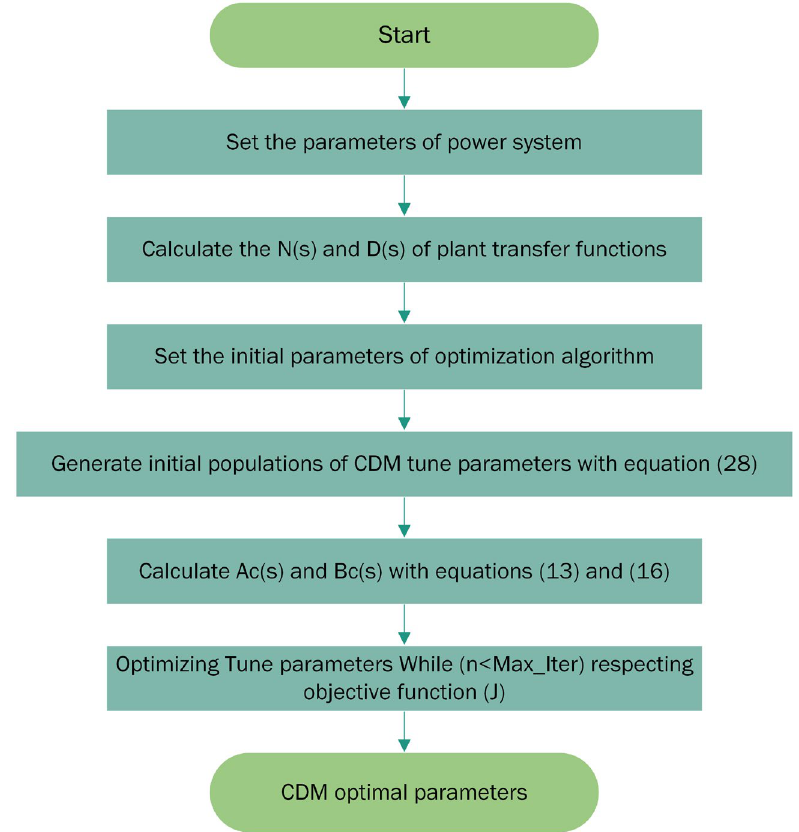
Fig. 3 Flowchart of procedure to tune CDM controller